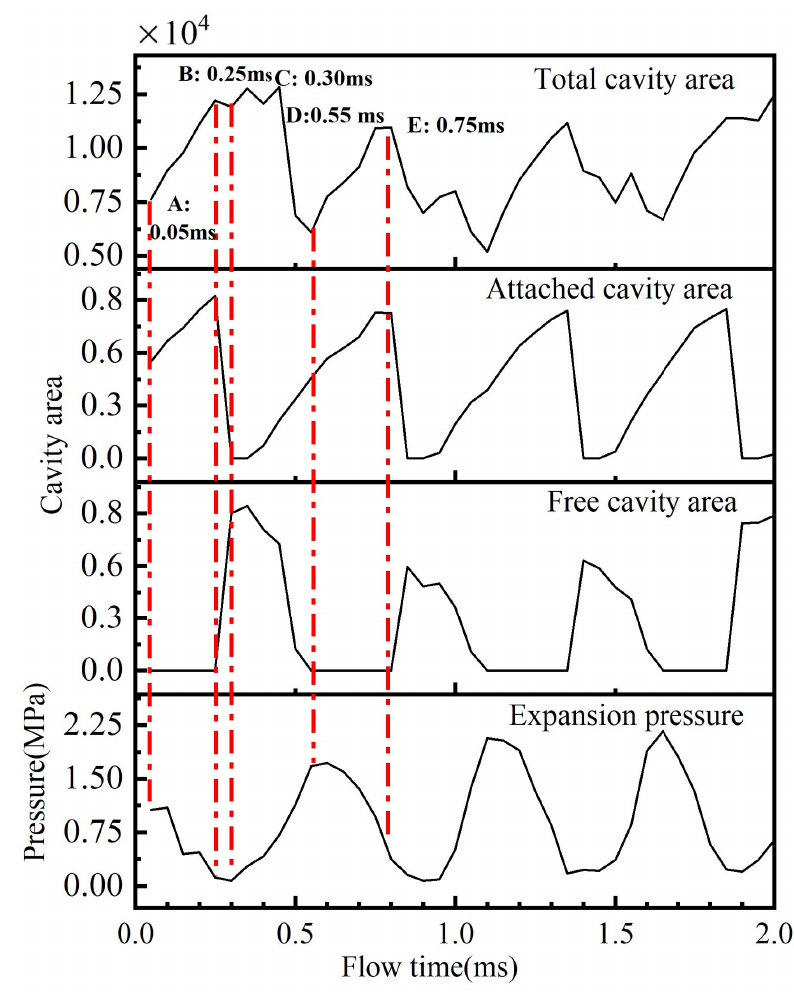
Figure 6. Variation of cavity area and excited pressure fluctuations while P in = 4.5 MPa, P out = 1.0 MPa and the opening is